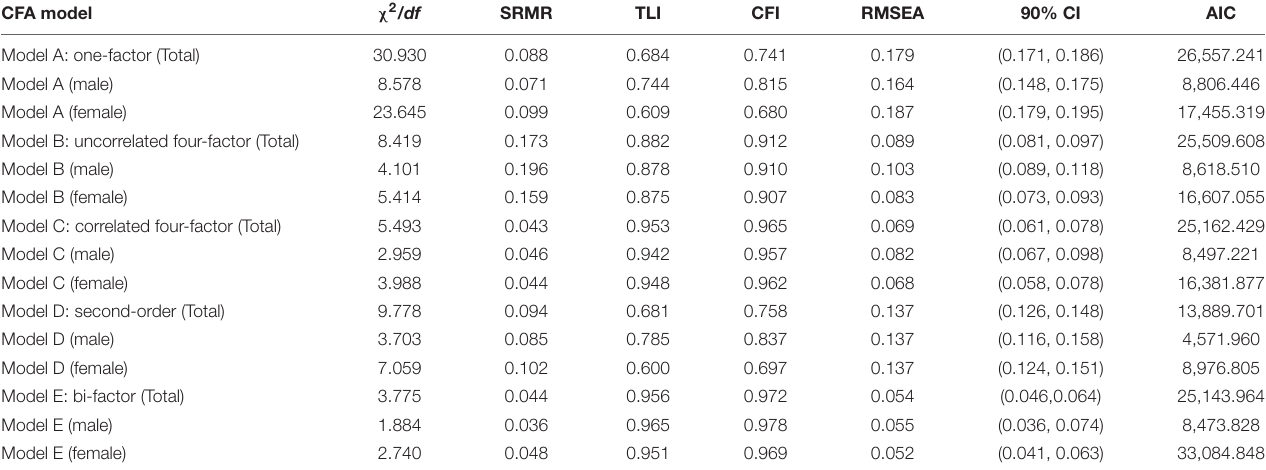
TABLE 3 | Fit indices for the five models